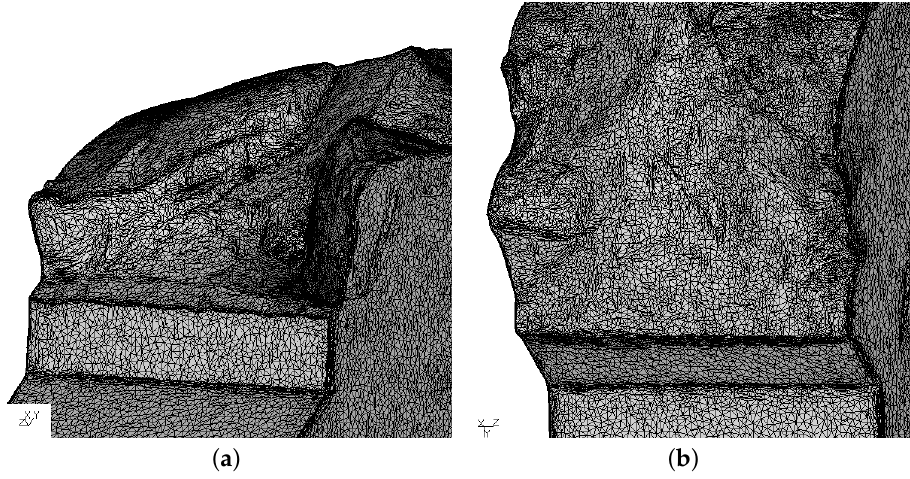
Figure 13. Experimental result: ( a ) 0_1_90_2 specimen; ( b ) 1_1_90_2